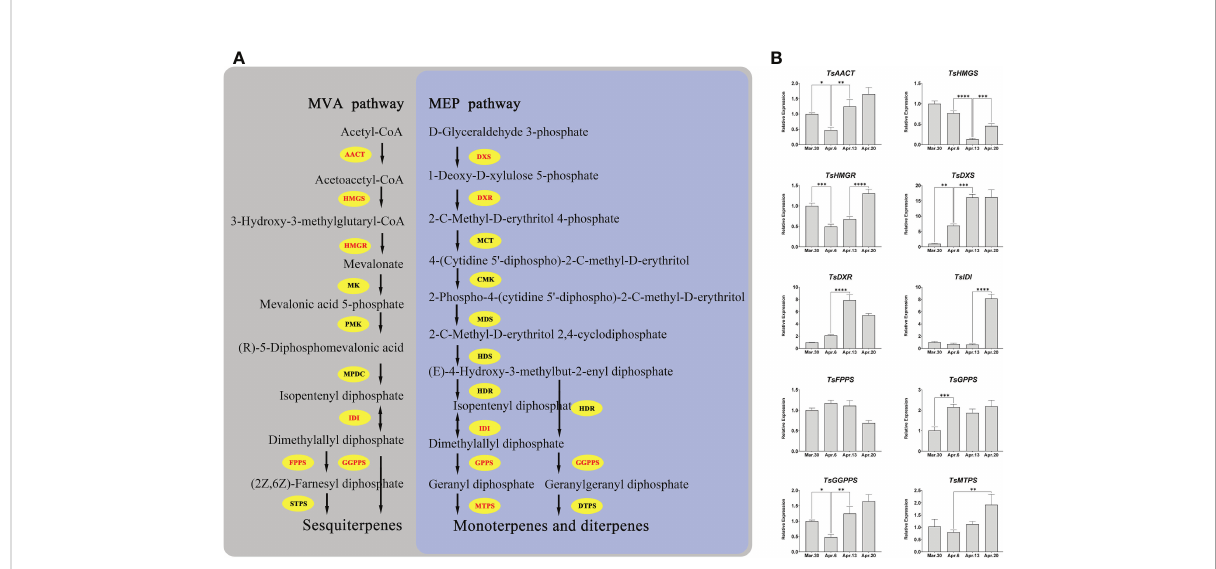
FIGURE 9 Pathways of terpenoid synthesis and the expression patterns of several key genes. (A) The main terpenoid biosynthesis pathway in plants; AACT , acetoacetyl-CoA thiolase; HMGS , 3-hydroxy-3-methylglutaryl-CoA synthase; HMGR , 3-hydroxy-3-methylglutaryl-CoA reductase; IDI , isopentenyl diphosphate isomerase; FPPS , farnesyl diphosphate synthase; DXS , 1-deoxyd-xylulose 5-phosphate synthase; DXR , 1-deoxy-D-xylulose 5-phosphate reductoisomerase; GPPS , geranyl diphosphate synthase; GGPPS , geranylgeranyl diphosphate synthases; PMK , phosphomevalonate kinase; MK , mevalonate kinase; MPDC , mevalonate diphosphate decarboxylase; MCT , 2-C-methyl-D-erythritol 4-phosphate cytidylyltransferase; CMK , 4-(cytidine 5 ’ -diphospho)-2-C-methyl-D-erythritol kinase; MDS , 2-C-methyld-erythritol 2,4-cyclodiphosphate synthase; HDS , (E) -4-hydroxy-3-methylbut-2-enyl diphosphate synthase; HDR , (E) -4-hydroxy-3-methylbut-2-enyl diphosphate reductase; STPS , sesquiterpene synthase; MTPS , monoterpene synthase; DTPS , diterpene synthase. (B) *, **, ***, and **** mean a signi fi cant difference at P < 0.05, P < 0.01, P < 0.001, and P < 0.0001,